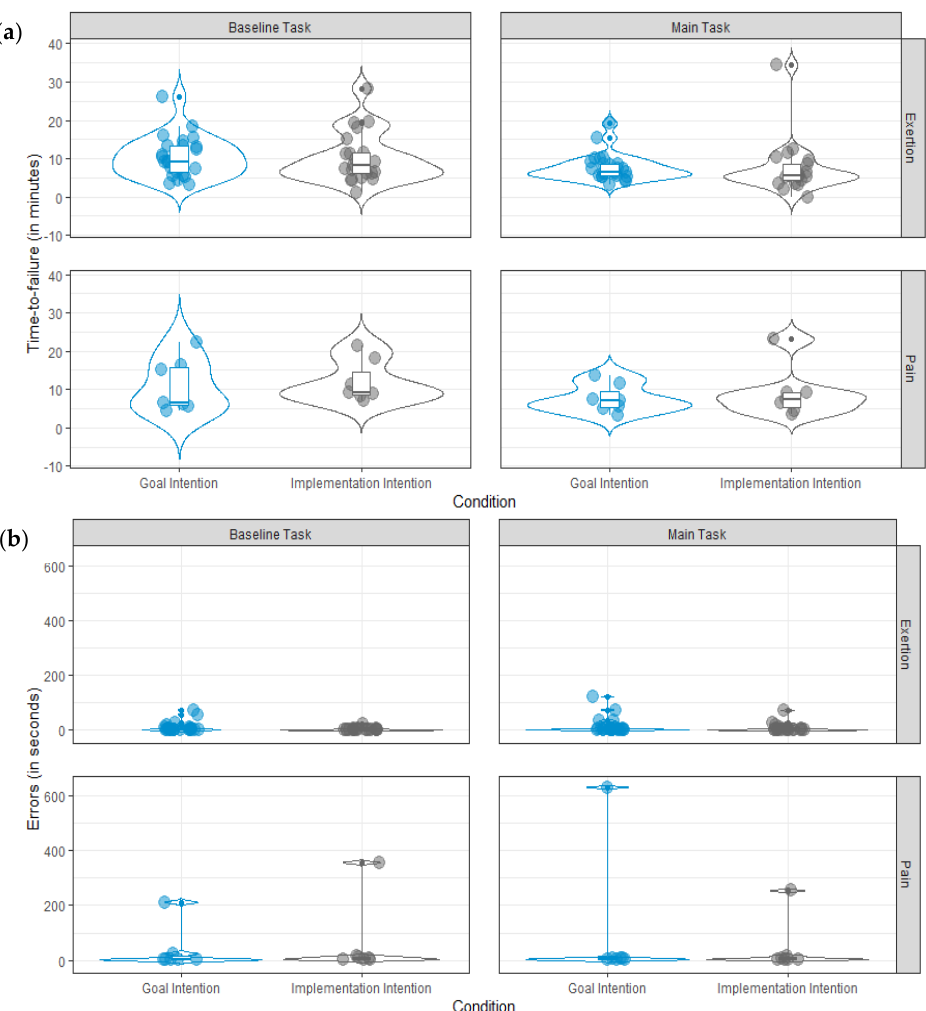
Figure 2. Violin plots and boxplots of ( a ) time-to-failure and ( b ) errors as a function of Condition (goal vs. implementation intention) and the reason for T1 task termination (Limit: exertion vs. pain).